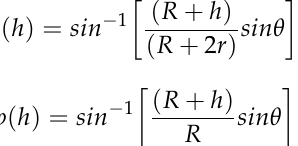
Refractive Index (n) 30% v / v E–W 50% v/v E–W 70% v / v E–W